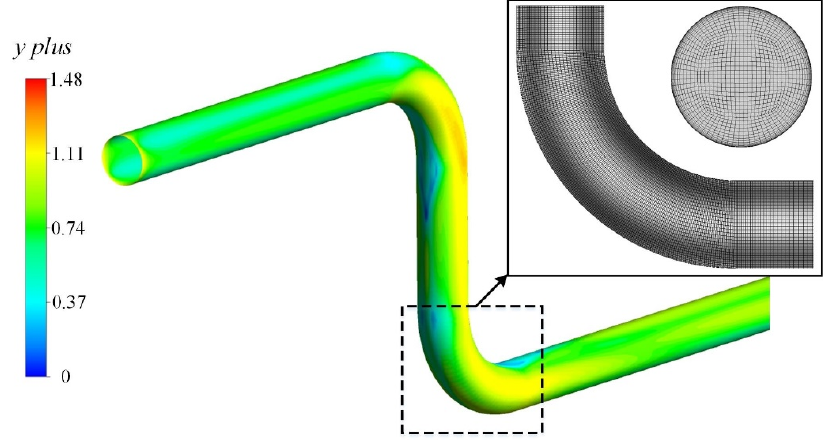
Figure 3. Contour of y + and details of mesh 2.